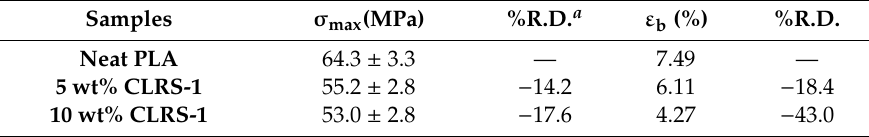
Table 2. Tensile properties of PLA and PLA / CLRS-1 printed samples.